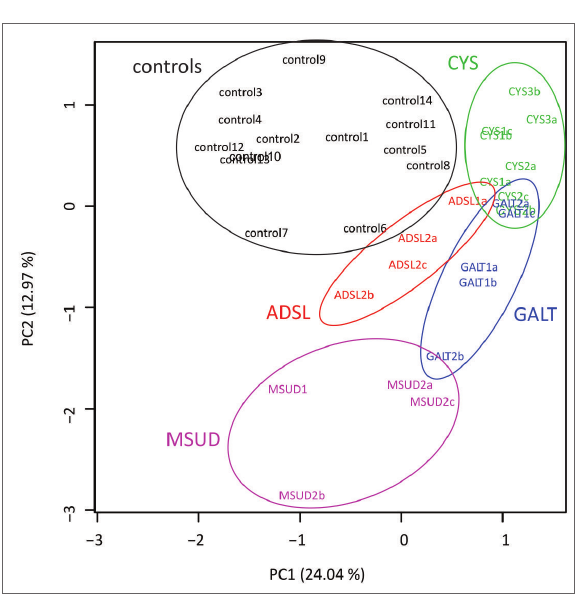
Fig. 1. Principal component analysis of urine samples. Fig. 2. Principal components discriminant function analysis of urine